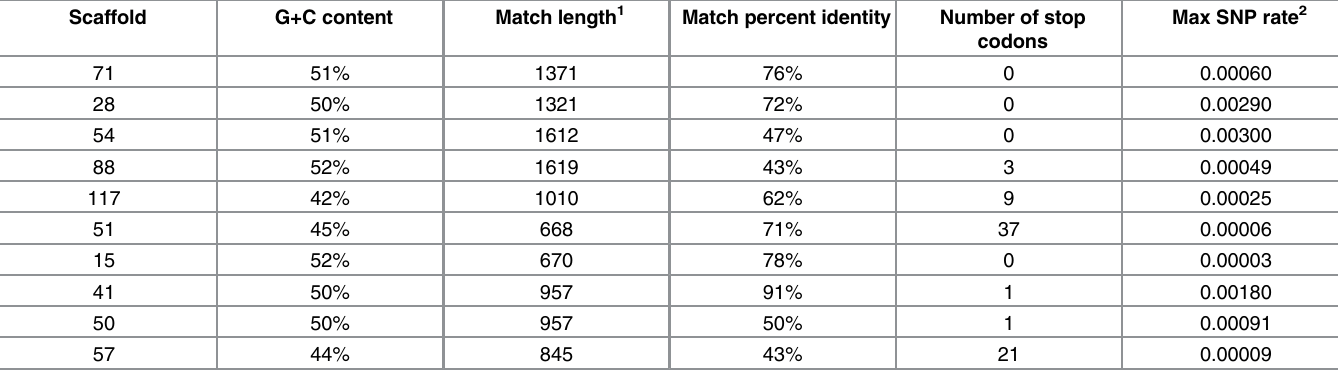
Table 5. SNP rates in 10 scaffolds with an RVT match and numbers of in-frame stop codons in the matches. Scaffold